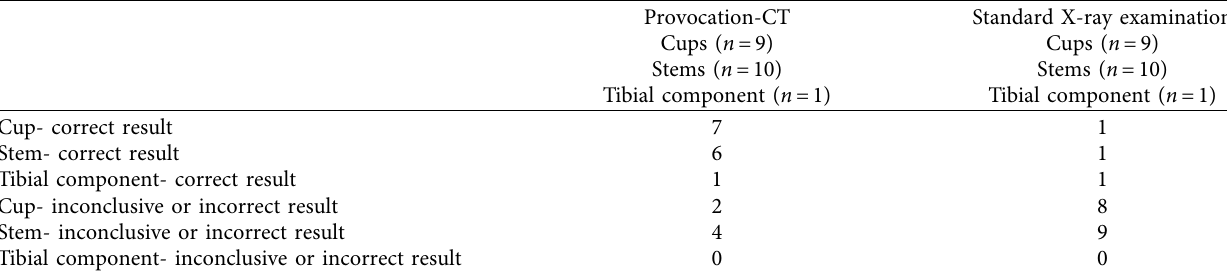
Table 3: Results after CT provocation and standard X-ray examination according to the surgical findings at